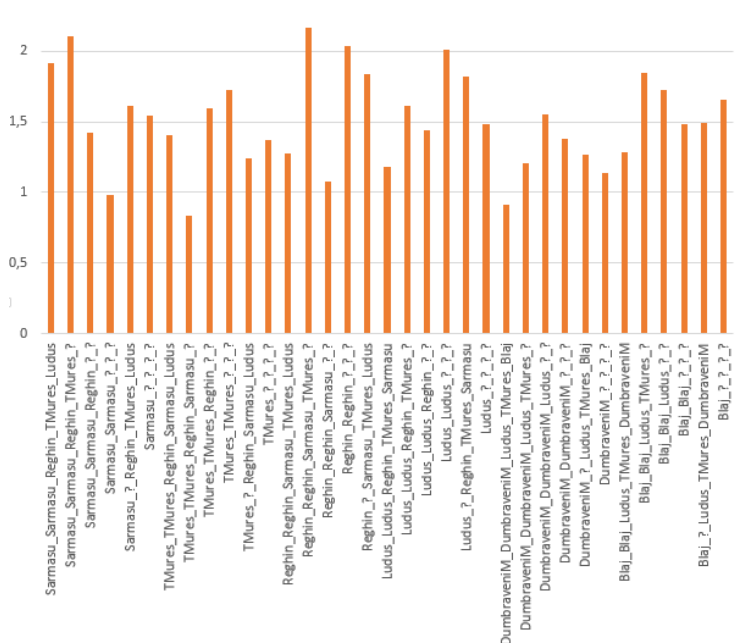
Figure 14. The standard deviations for k-NN algorithm with various setups: loc_context_colsrc1_colsrc2_colsrc3 ( X -axis) where loc is the location for which the prediction is run, context is the contextual data for that location, colsrc1 , colsrc2 and colsrc3 are the collaborative data sources, and the value of standard deviation ( Y -axis); ? denotes missing data